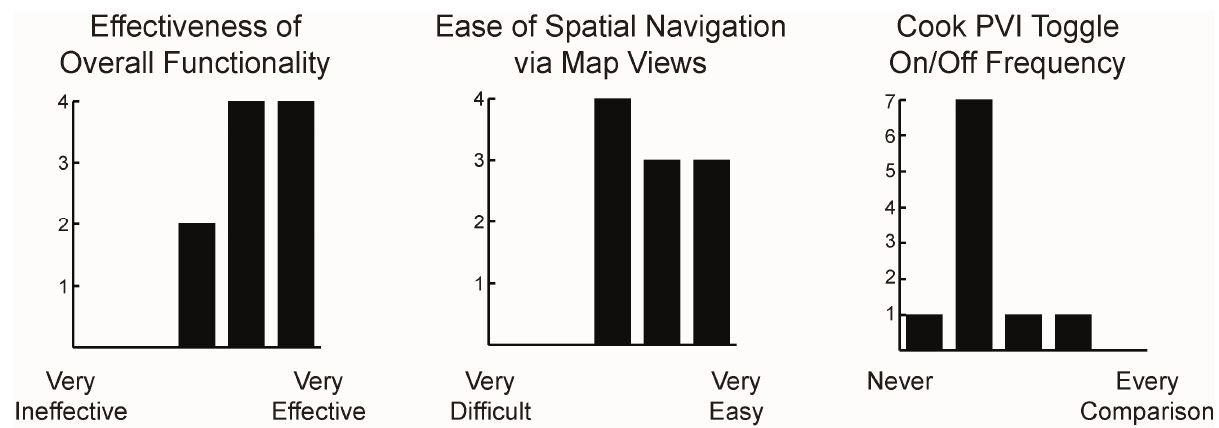
Figure 12. Ratings on SPoTvis’ functionality ( left ), ease of spatial navigation ( middle ), and Cook PVI toggle frequency ( right ). Each graph depicts the frequency of response on a five-step Likert scale with the end points labeled using the terms shown below the